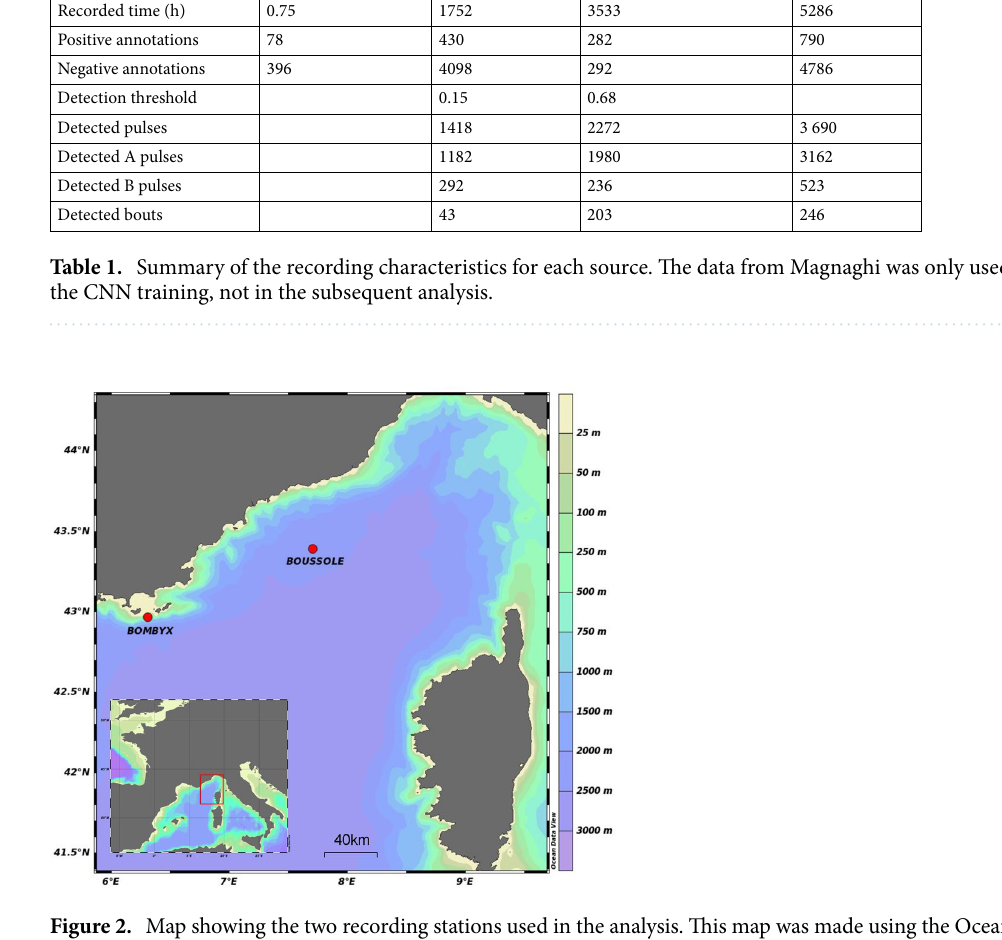
Figure 2. Map showing the two recording stations used in the analysis. This map was made using the Ocean Data View software 39